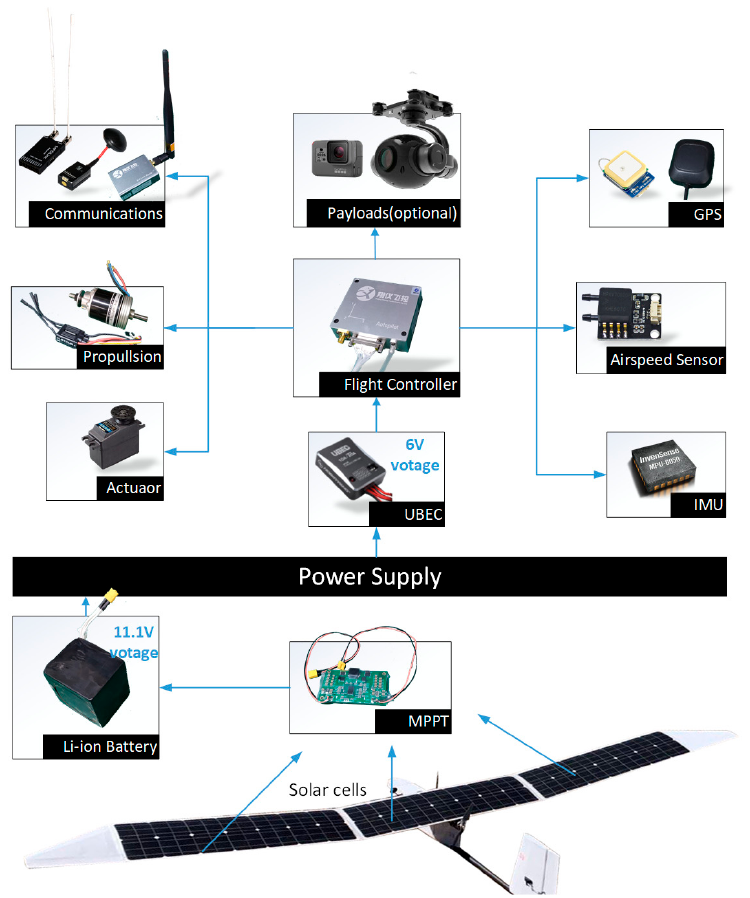
Figure 10. Topological system overview over the MP Solar UAV.